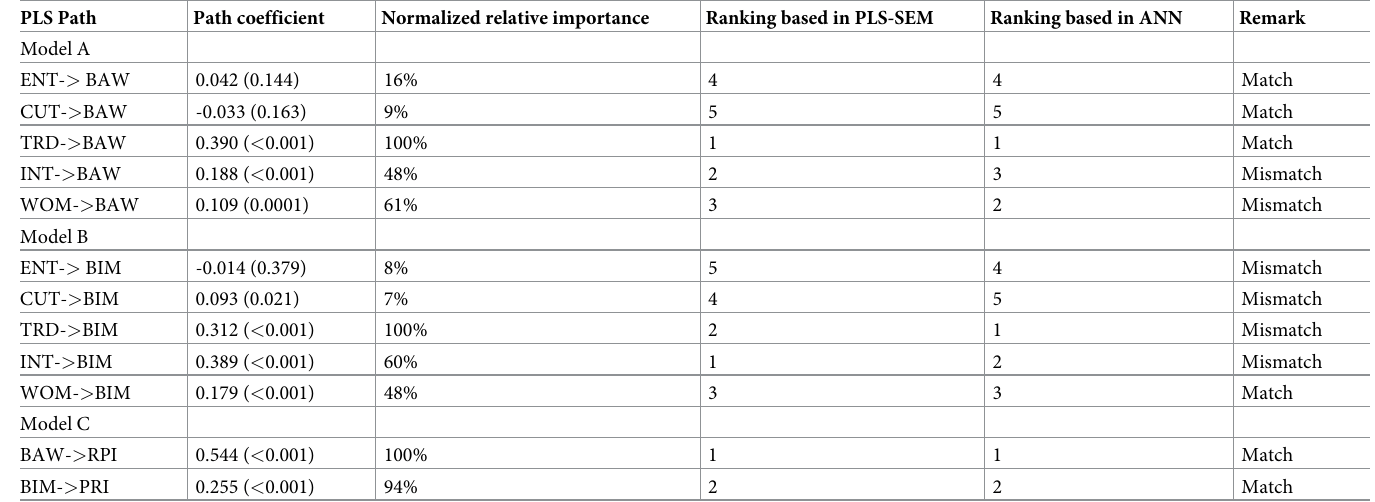
Table 10. Comparision between PLS-SEM and ANN